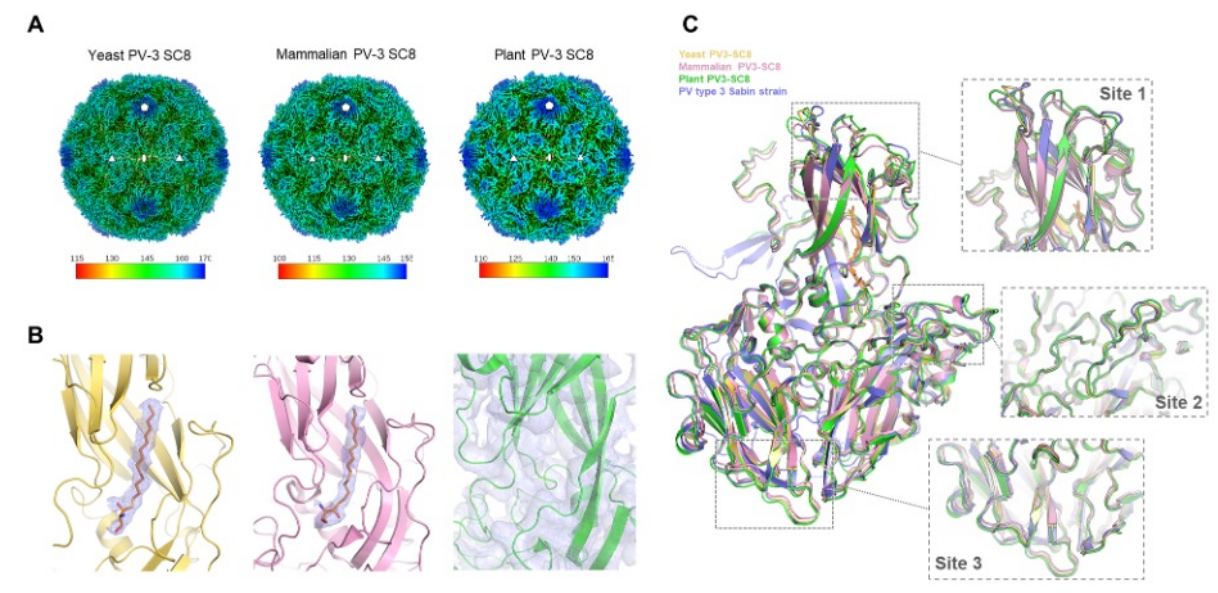
Figure 5. Comparison of PV-3 SC8 VLPs produced in plant, mammalian and yeast cells. ( A ): Three dimensional cryo-EM reconstructions of PV-3 SC8 VLPs expressed in yeast, mammalian and plant cells. The VLPs are viewed along the icosahedral twofold symmetry axis and coloured by radial distance in Å from the particle center according to the colour keys provided. Five, three and twofold symmetry axes are labelled with symbols. ( B ): Close-up views of the capsid protomer VP1 subunit hydrophobic pocket for the yeast (pale yellow), mammalian (pink) and plant (green) produced VLPs. Cryo-EM density maps are shown rendered around the VP1 protein for plant PV-3 SC8, or around the modelled sphingosine lipid in the yeast and mammalian PV-3 SC8 VLPs. ( C ): Structural superposition of the capsid protomers of yeast (pale yellow, PDB 8ANW), mammalian (pink, PDB 6Z6W) and plant (green, PDB 5O5B) produced PV-3 SC8 VLPs with the structure of the PV-3 virus sabin strain (blue, PDB 1PVC). The sphingosine lipid modelled in the VP1 pockets of yeast and mammalian PV-3 SC8 VLPs and PV-3 sabin virus are shown as orange sticks. Boxes highlight antigenic sites on the VP1, VP2 and VP3 subunits of the capsid protein and are shown in expanded views labelled as site 1, site 2 and site 3, respectively.